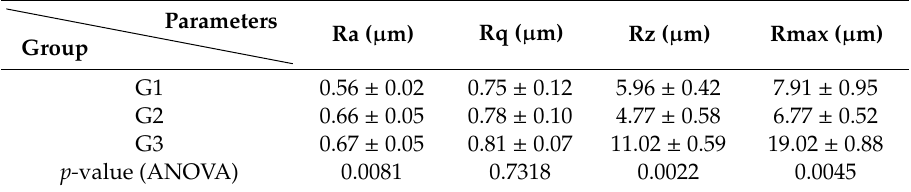
Table 1. Mean value and standard deviation (±SD) of the measured roughness and surface parameters in micrometers (µm).